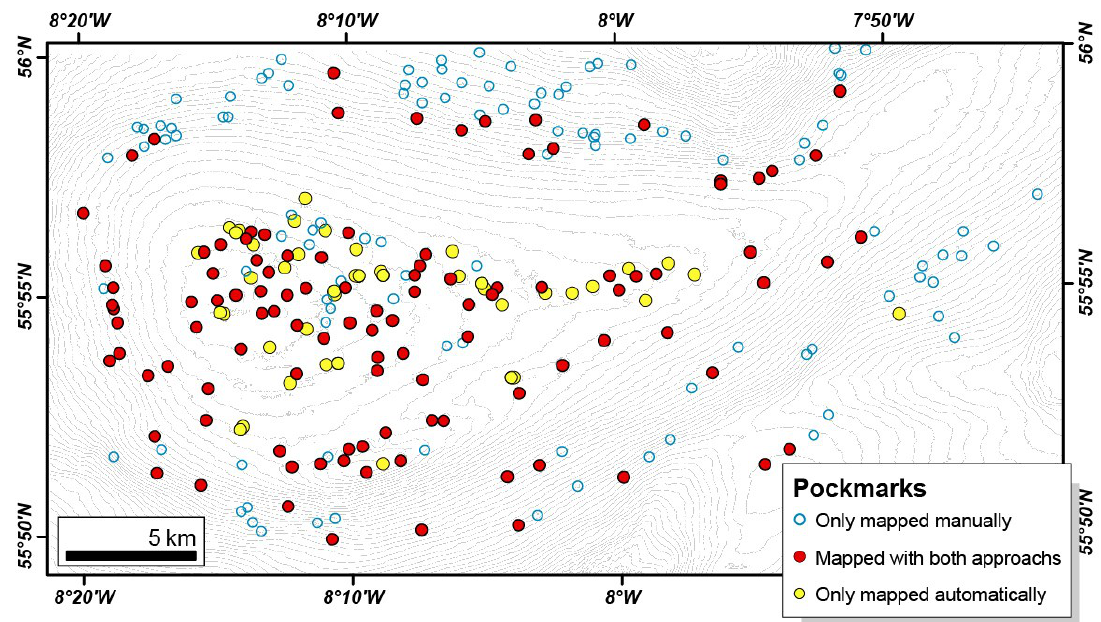
Figure 18. Malin Deep’s pockmarks distribution based on both manual and semi-automatic mapping. Based on the manual mapping, the pockmarks were described as being between 40 and 850 m wide, and up to 8.5 m deep, with a mean length of 124 m and mean vertical relief of 1.02 m [32]. These measurements present higher vertical relief than the values extracted by the semi-automatic method. We believe that this difference also results from the need to smooth, in this case, the bathymetry before applying the Feature Delineation [Bathy]